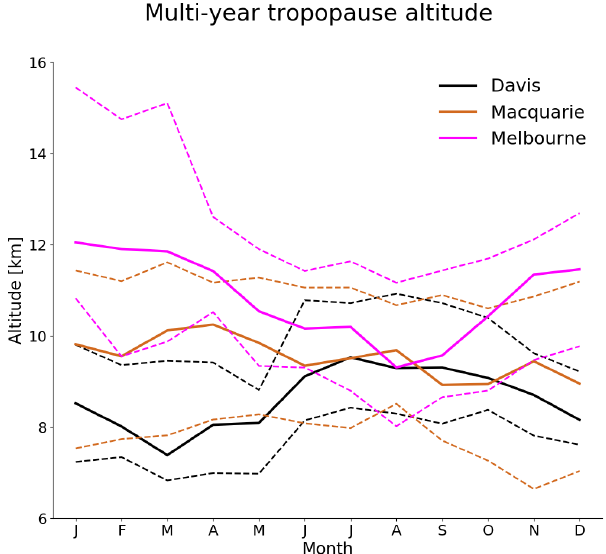
Figure 2. Multi-year monthly median tropopause altitude (using the ozone-defined tropopause) determined from ozonesondes measure- ments at Davis (2006–2013), Macquarie Island (2004–2013), and Melbourne (2004–2013) (solid lines). Dashed lines show the 10th to the 90th percentile of tropopause altitude for each